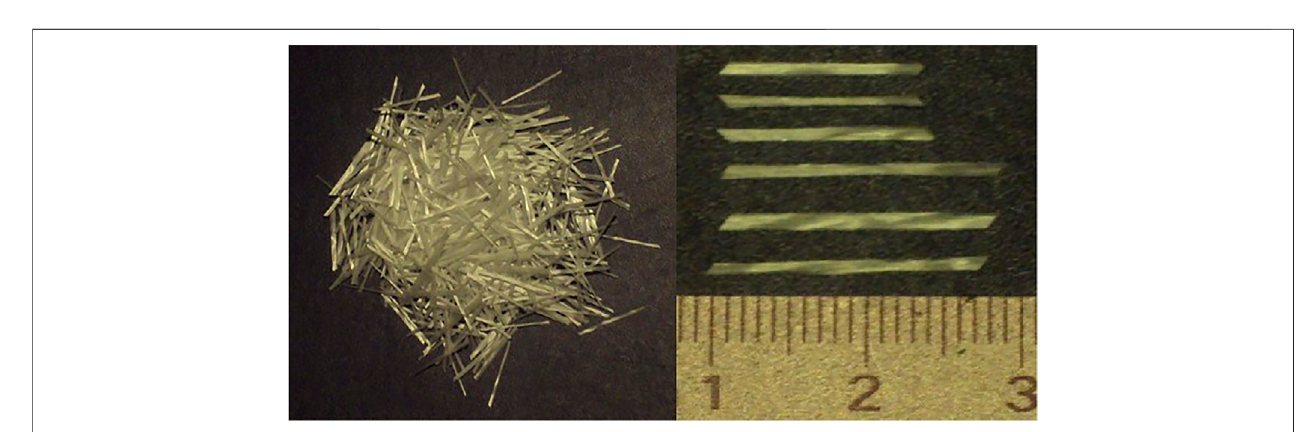
FIGURE 6 | Glass fi ber and